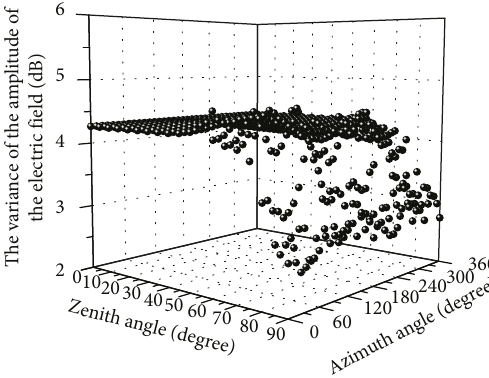
Figure 14: The variance of the amplitude of the electric fi eld for di ff erent inclination angles in the NLOS